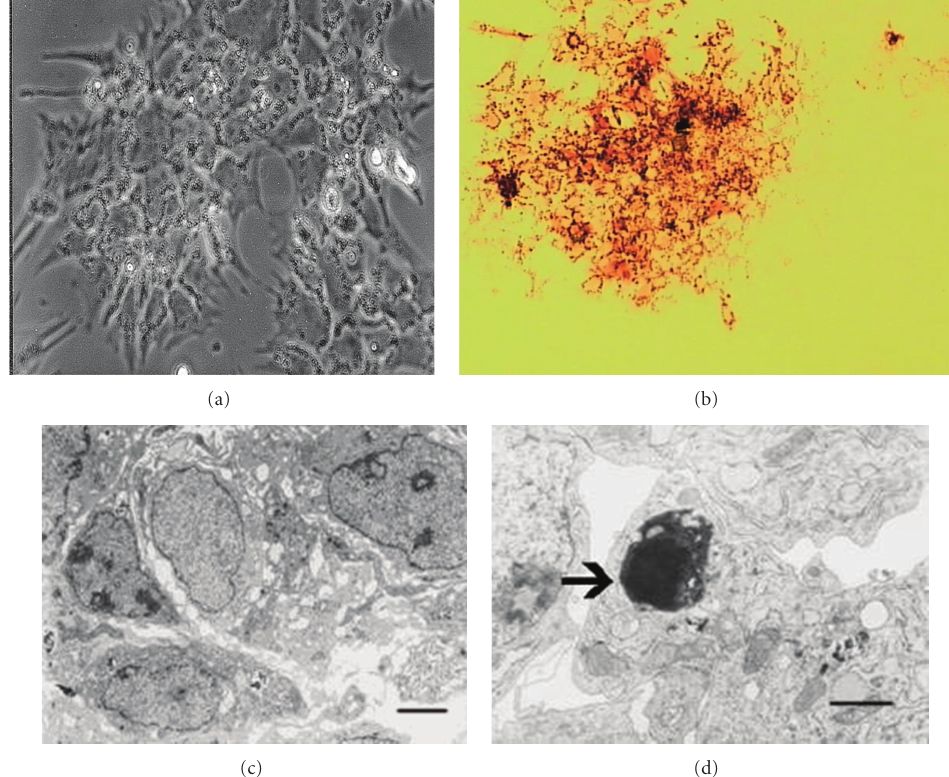
Figure 1: Cultured IEC exhibited a cobblestone morphology (light microscope 200x). (b) More than 90% of the attached cells were positive for alkaline phosphatase (light microscope 200x). (c) Microvilli on the surface of the IEC (transmission electron microscope 5000x). (d) Apoptotic body (Arrowed) (Transmission electron microscope, 5000x). Scale bar = 2 μ m.